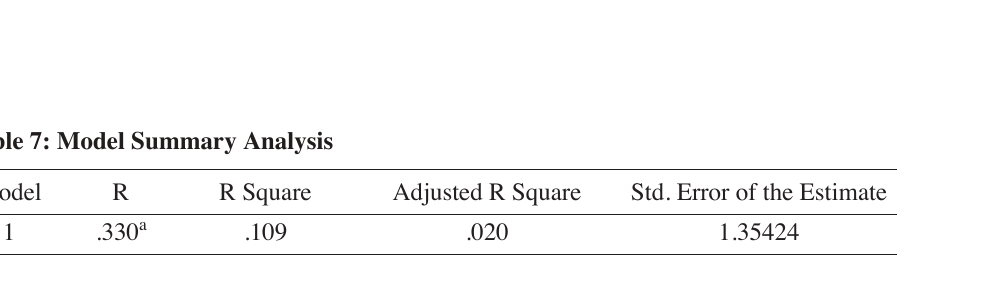
Analysis of Variance (ANOVA)